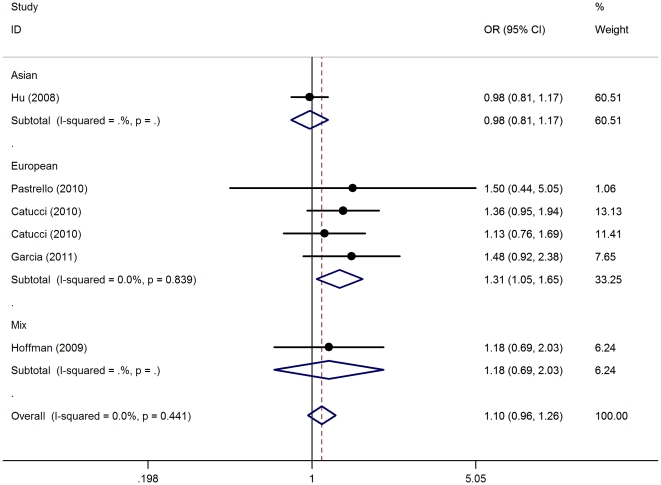
Meta-analysis with a fixed-effects model for the association between breast cancer risk and the has-miR-146a rs2910164 polymorphism (CC vs GC+GG) is illustrated in subgroup analysis by ethnicity.OR: odds ratio; CI: confidence interval; I2, measure to quantify the degree of heterogeneity in meta-analyses.